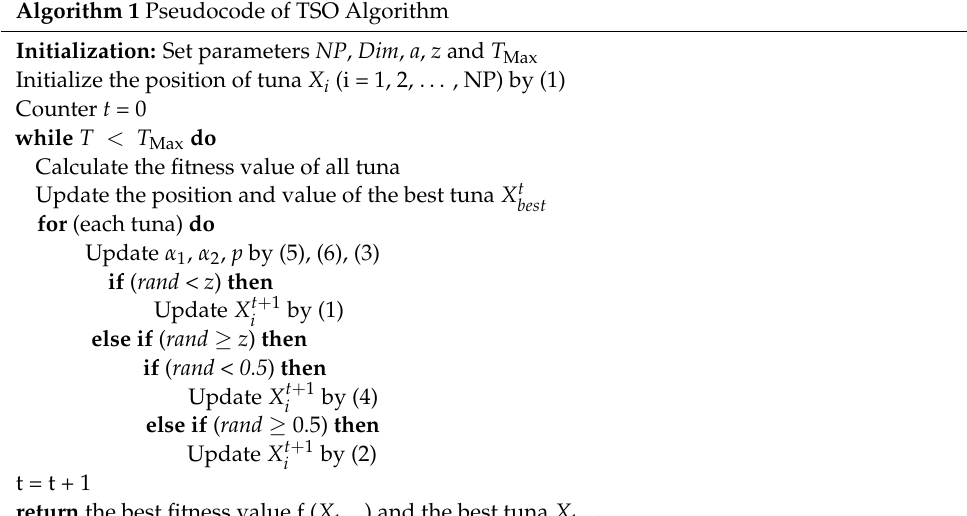
Algorithm 1 Pseudocode of TSO